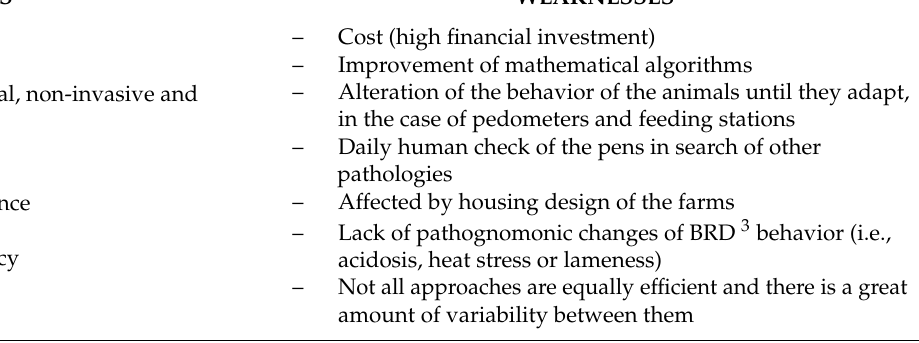
Table 2. Weaknesses, threats, strengths and opportunities (SWOT) analysis of the use of behavior assessment systems (BAS) as technological tools to diagnose BRD in cattle.